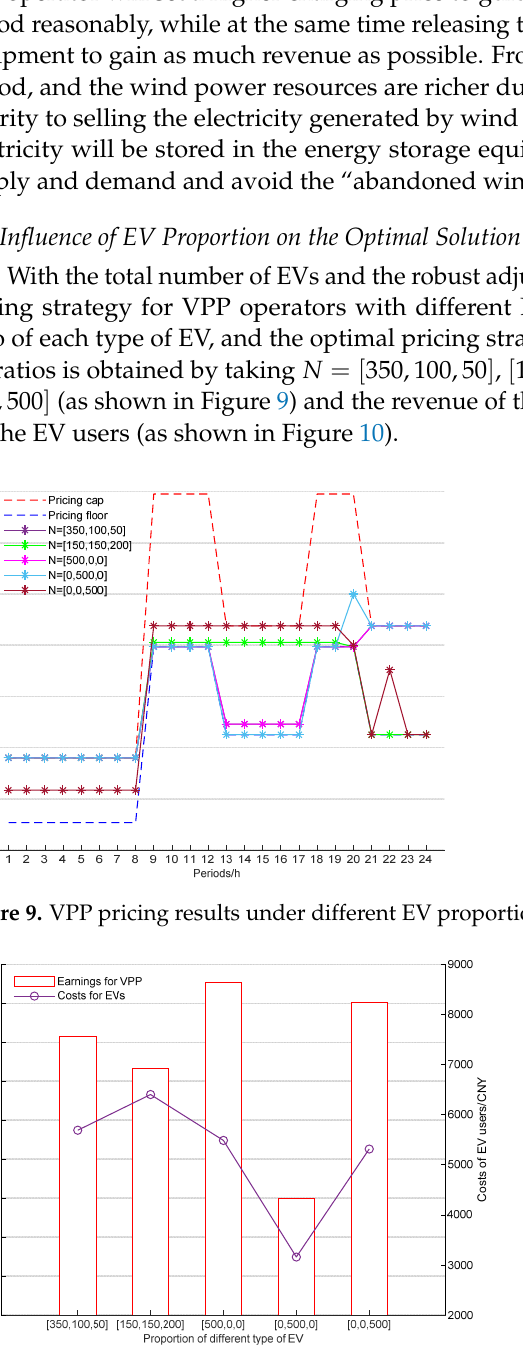
Figure 10. Optimization results of VPP operating benefits and EV power purchase costs .